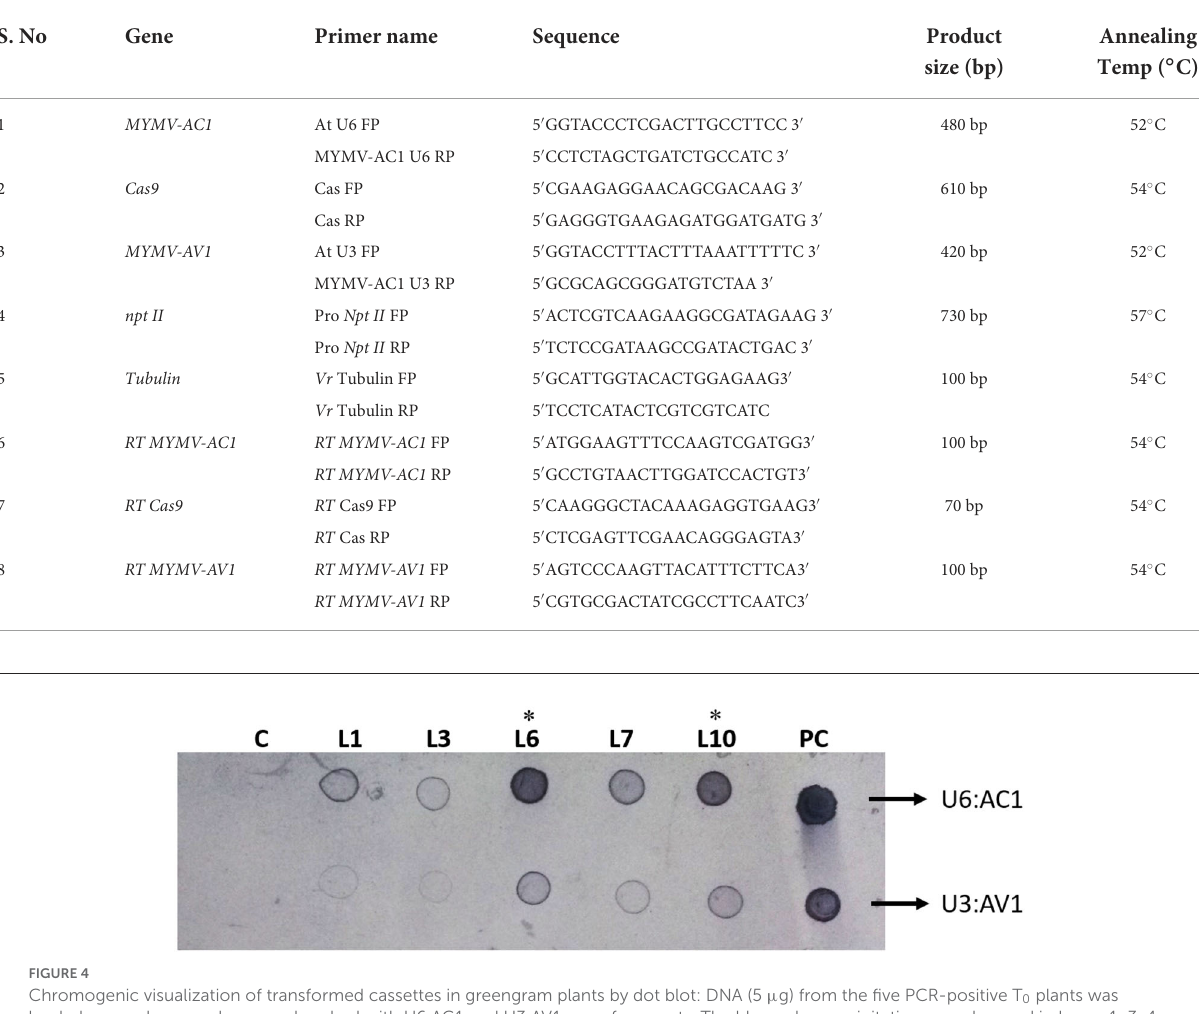
TABLE 1 Primers used for detection of transgenes and transcript analysis.